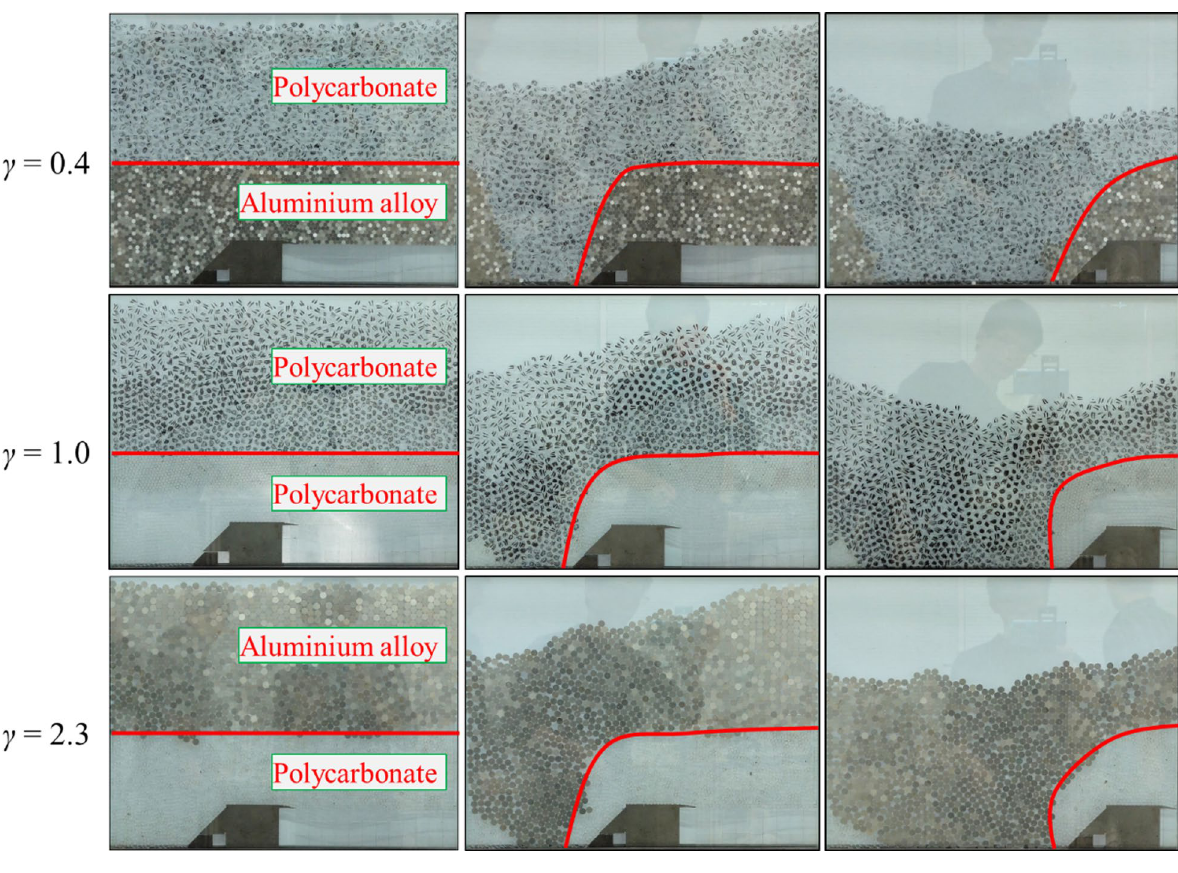
Fig. 26 Physical experiments with different γ